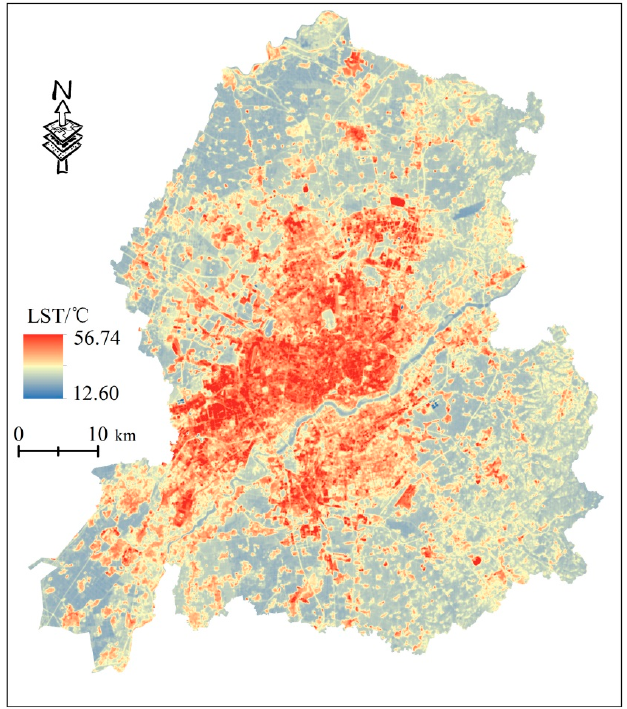
Figure 3. Land surface temperature inversion results.